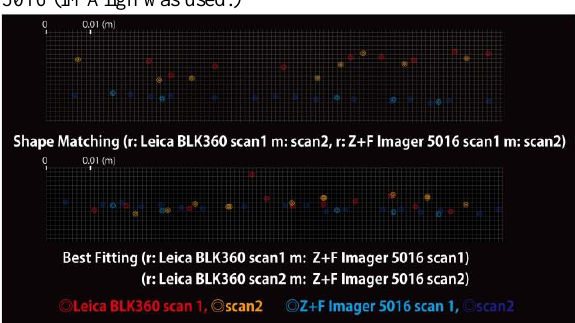
Figure 4: The Histgrams of Leica BLK360 and Z+F Imager 5016 (IMAlign was used.)